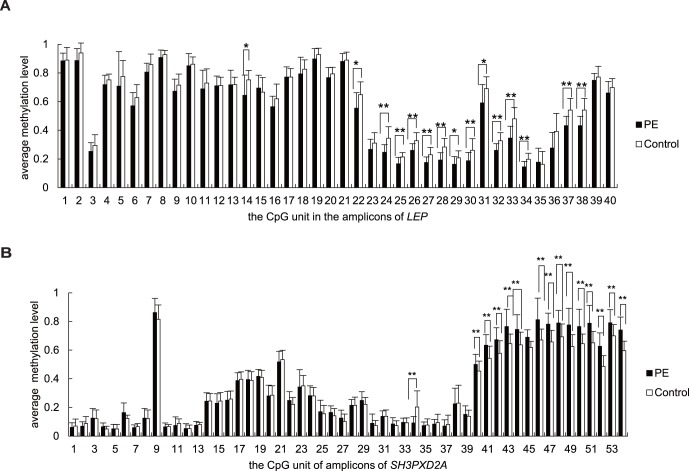
Quantitative DNA methylation of LEP and SH3PXD2A in all PE (n = 16) and control (n = 16) samples.(A) The average methylation level of the CGI of LEP. Several CpG sites in the vicinity of TSS (unit 34) are all significantly hypomethylated in the preeclamptic placentas. Position with significantly differential methylation between PE and control groups is marked by asterisks. **p<0.01, *p<0.05. (B) The average methylation level of CGIs of SH3PXD2A. The TSS CGI comprised the CpG sites from unit 1 to13; The CGI74 comprised the CpG sites from unit 14 to 30; The CGI18 comprised the CpG sites from unit 31 to 39; The CGI34 comprised the CpG sites from unit 40 to 54. Position with significantly differential methylation between PE and control groups is marked by asterisks. **p<0.01, *p<0.05.